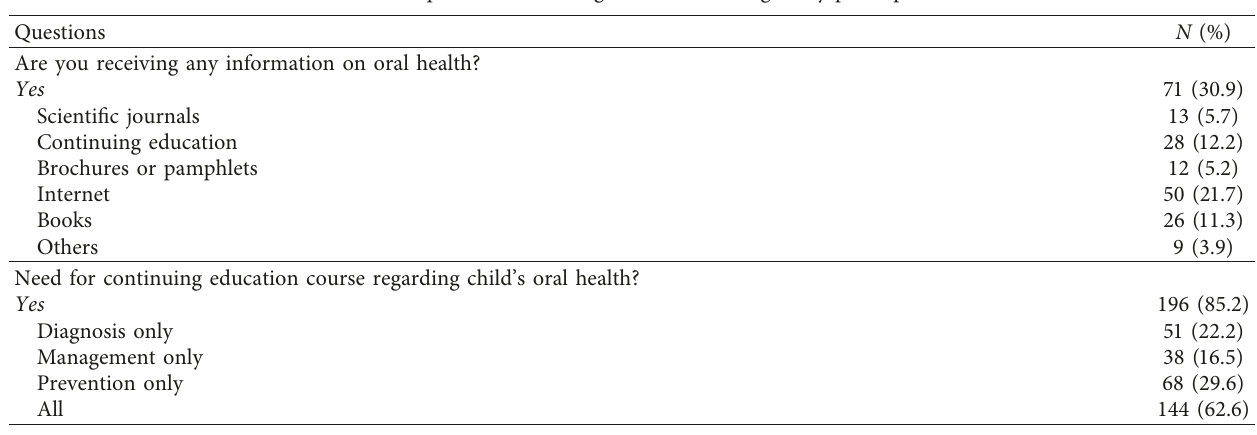
Table 5: Aspects of continuing education among study